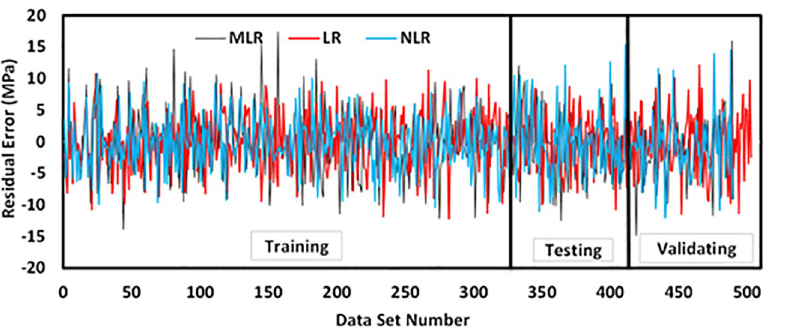
Fig 15. Residual error diagram of compressive strength of fly ash-based geopolymer concrete mixtures using training, testing, and validating dataset for all models.